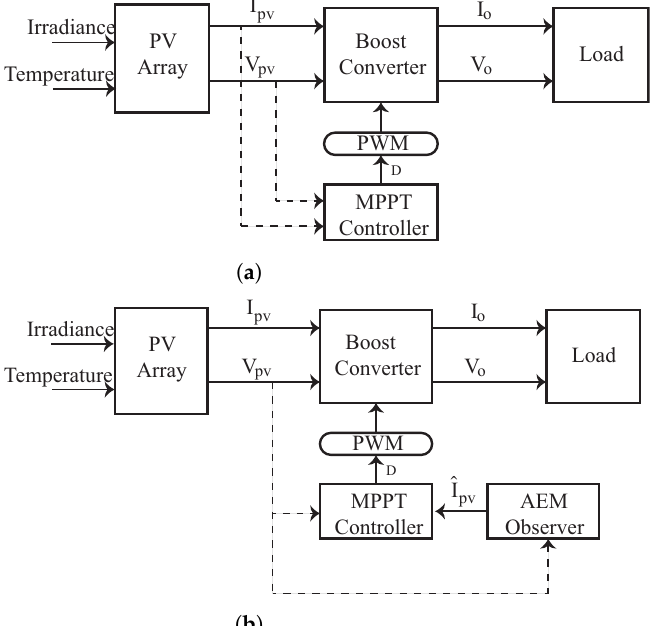
Figure 1. PV System’s configurations. ( a ) Conventional PV system with voltage and current sensors; ( b ) Proposed PV system with current